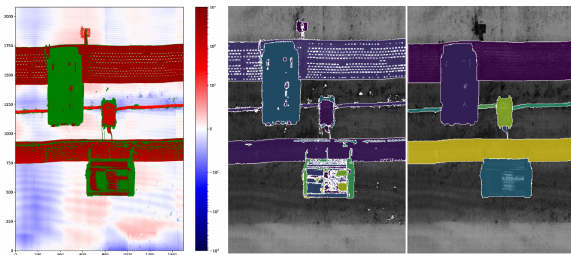
Figure 5. (Left) Residuals of robust surface adjustment. Invalid/out-of-range points appear in green. (Center) segmentation result. (Right) result after manual post-processing using S3A. Each object class appears in a different